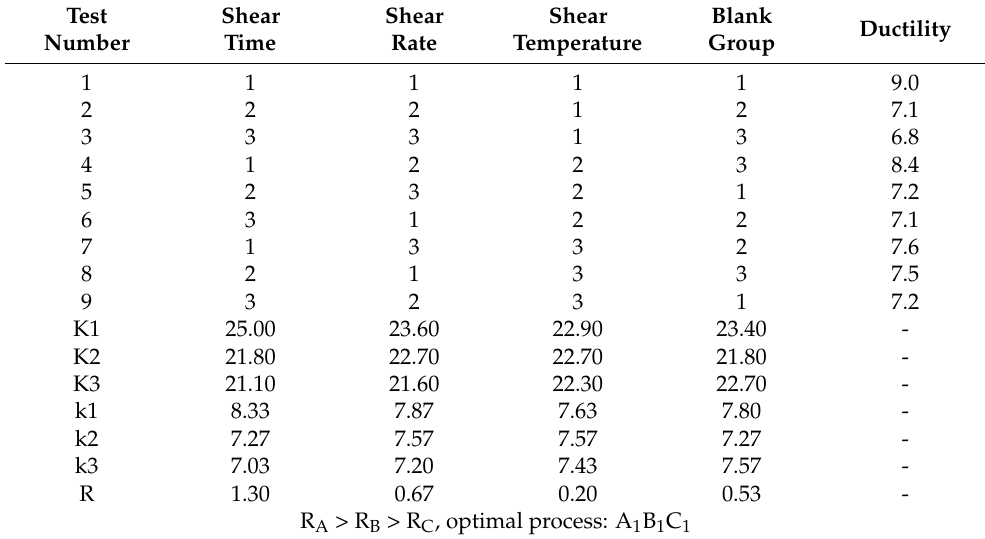
Table 8. Ductility range analysis results.